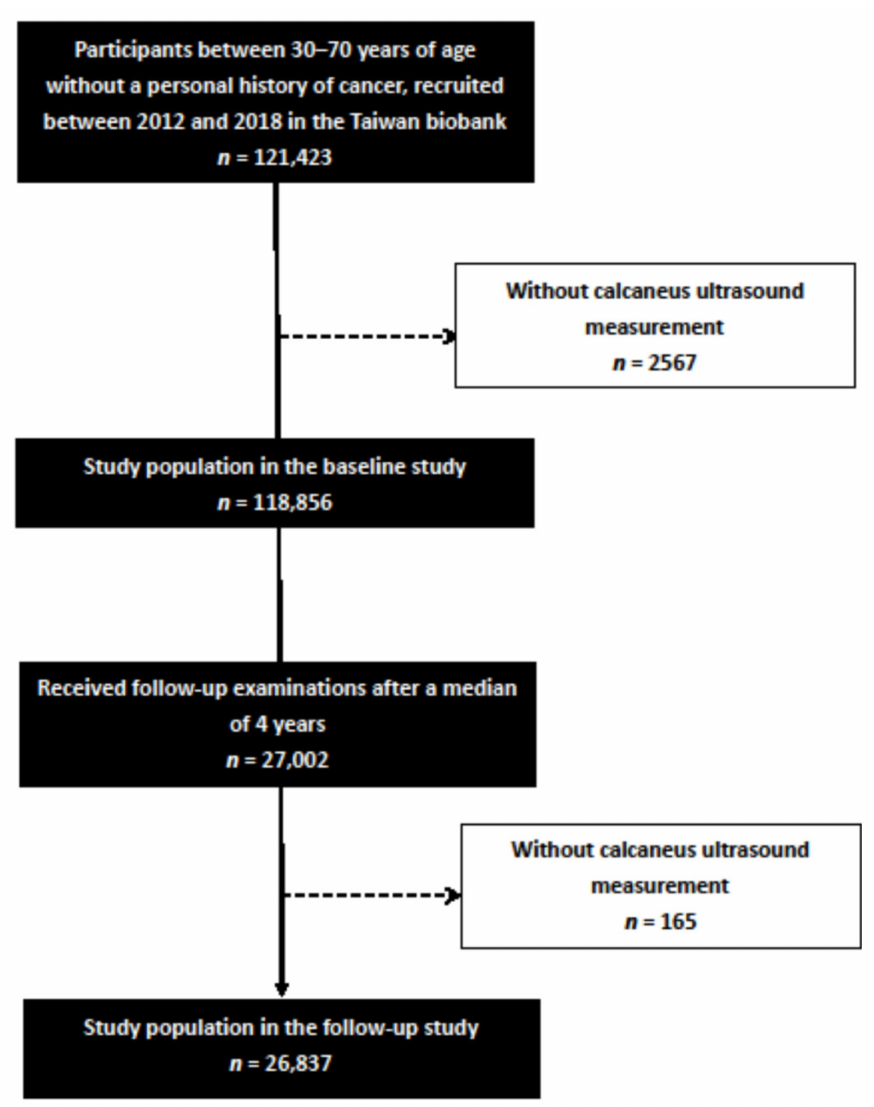
Figure 1. Flowchart of study